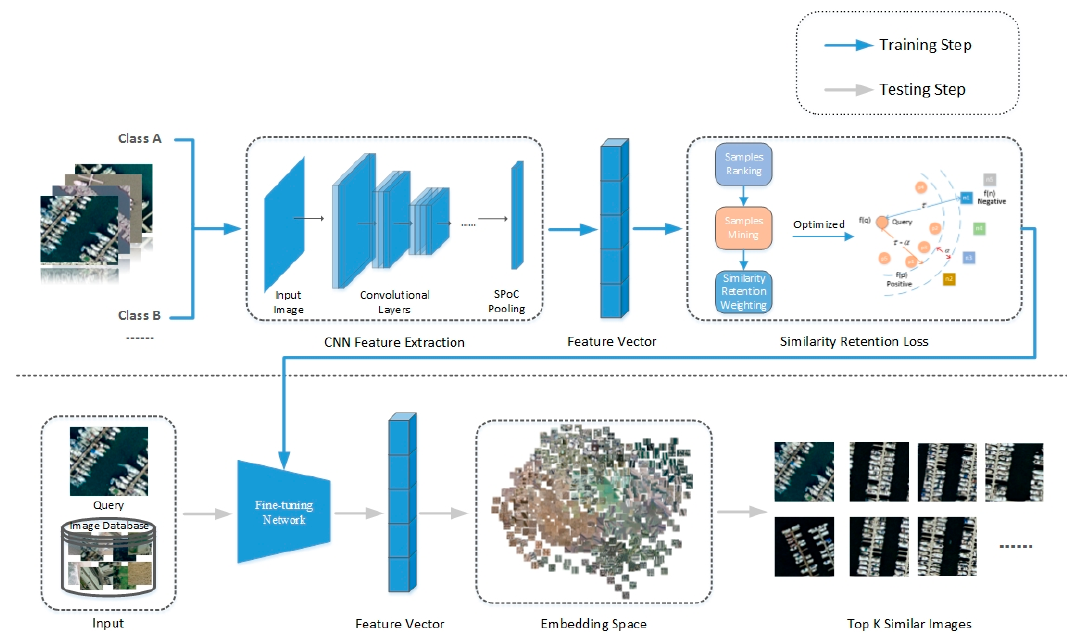
Figure 1. The overall framework of our proposed Similarity Retention Loss algorithm. The top is the training process of the samples in the network and the bottom is the testing process.